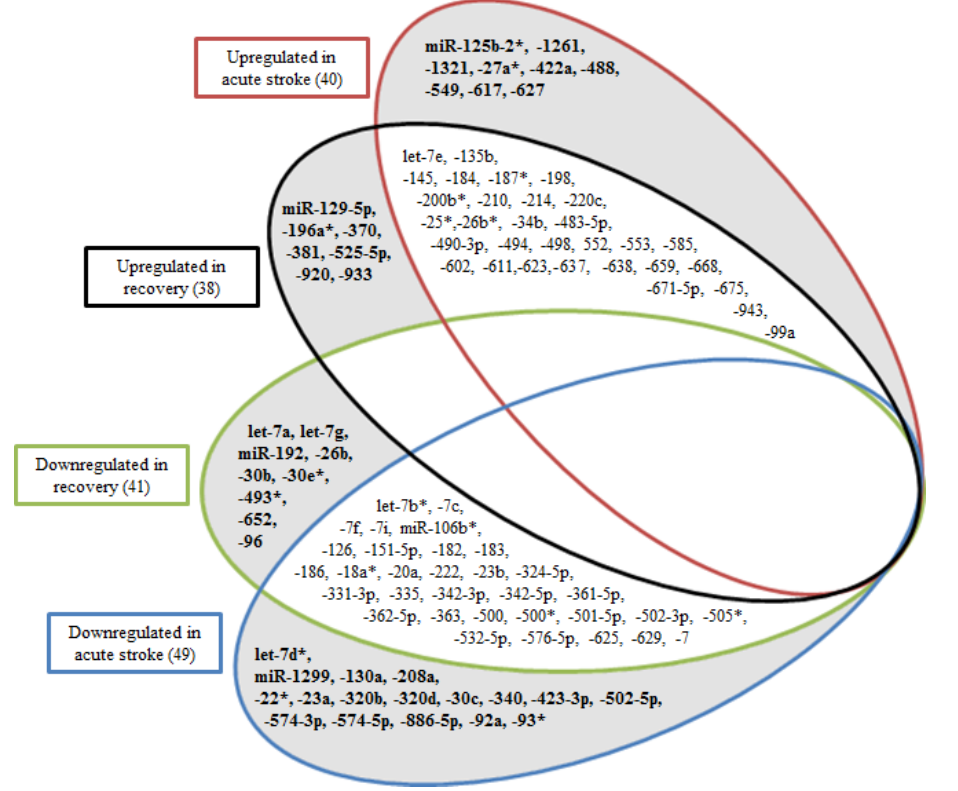
Figure 3. Differentially regulated miRNAs in stroke patients. miRNAs significantly altered (FDR p < 0.05) in acute stroke and recovery with respect to healthy controls are shown here. miRNAs unique to acute phase or recovery phase are represented in shaded regions in bold whereas those common to both categories are listed in the clear areas of the